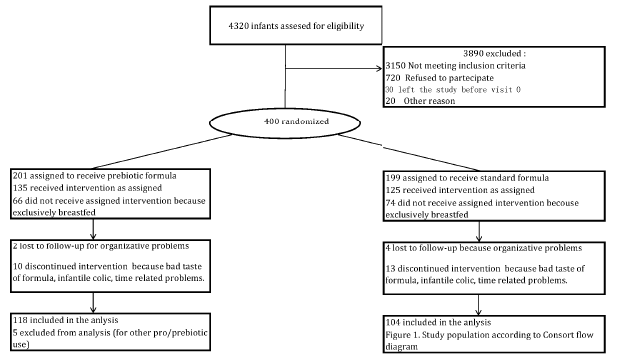
Figure 1. Study population according to CONSORT flow diagram.